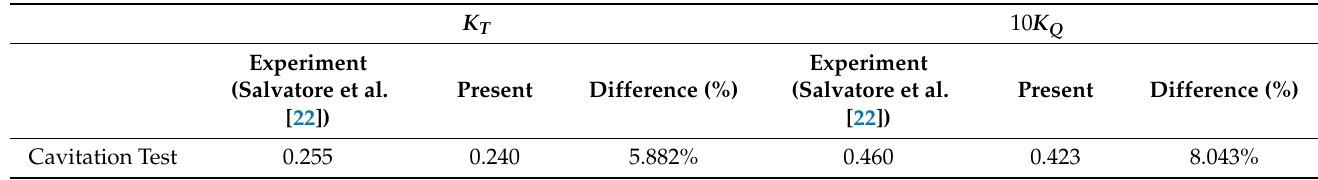
Table 3. Propeller propulsion coefficients for the case without duct and cavitation condition.